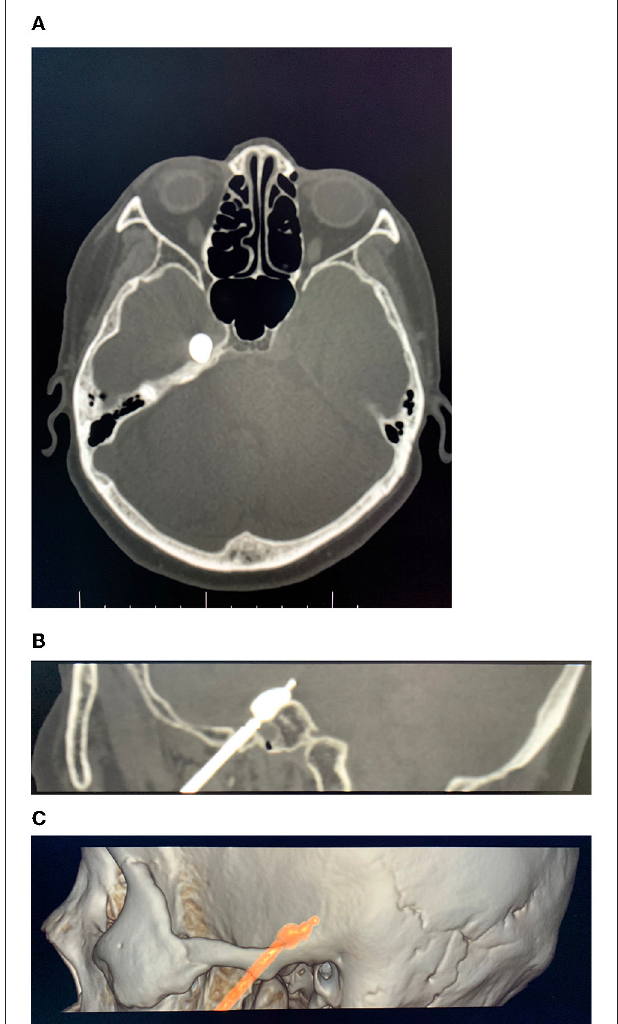
FIGURE 1 | Axial (A) and sagittal (B) computed tomography (CT) reconstruction images showing the balloon shape and position were correct (the white arrow points to the balloon). (C) Entry point and target